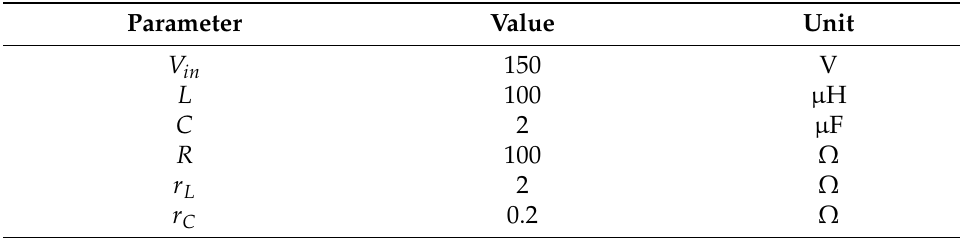
Table 1. Parameters of the boost converter.